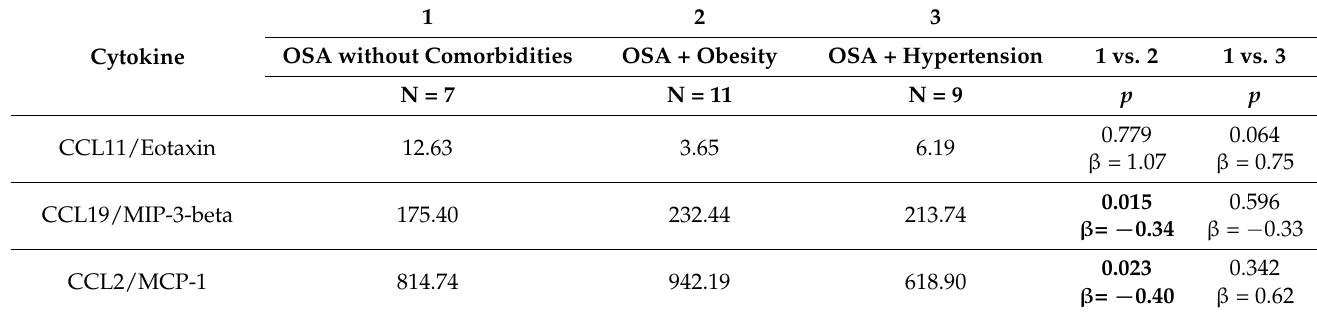
Table 5. Associations between cytokine levels in OSA patients without any other diseases vs. in OSA patients with concomitant only disorders: Obesity defined by BMI > 30 kg/m 2 or only with hyper- tension. Levels of cytokines in patients with/without given disorder are presented as mean values. Mann–Whitney U Test was used for calculations. β —standardized mean difference. Statistically significant results ( p ≤ 0.05) are shown in